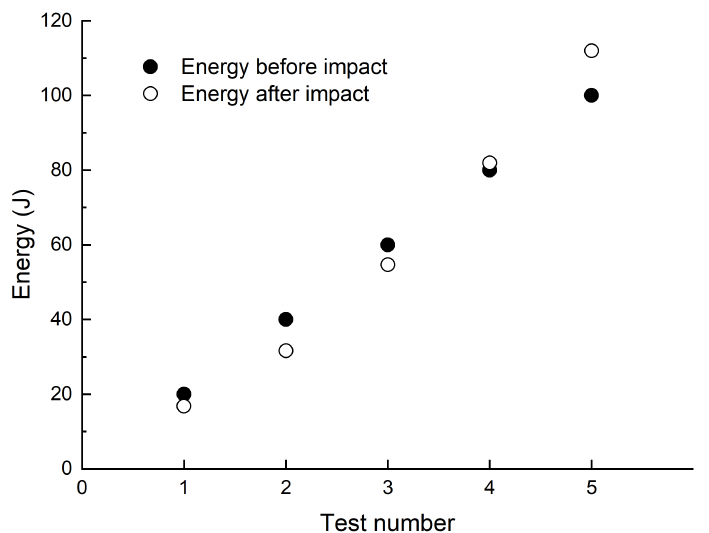
Figure 6. Comparison of the energy before impact and after to demonstrate energy